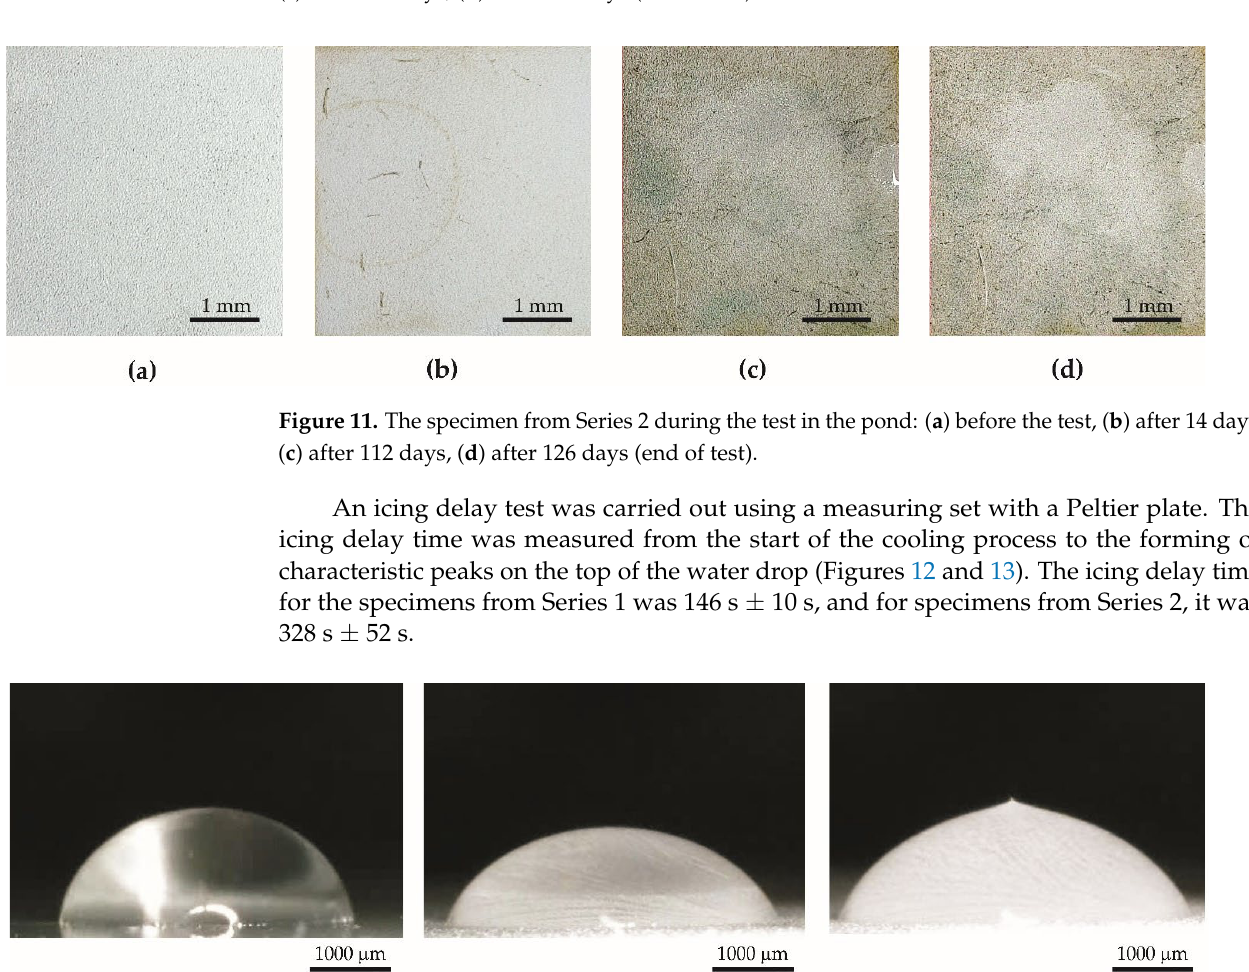
Figure 10. The specimen from Series 1 during the test in the pond: ( a ) before the test, ( b ) after 14 days, ( c ) after 112 days, ( d ) after 126 days (end of test).